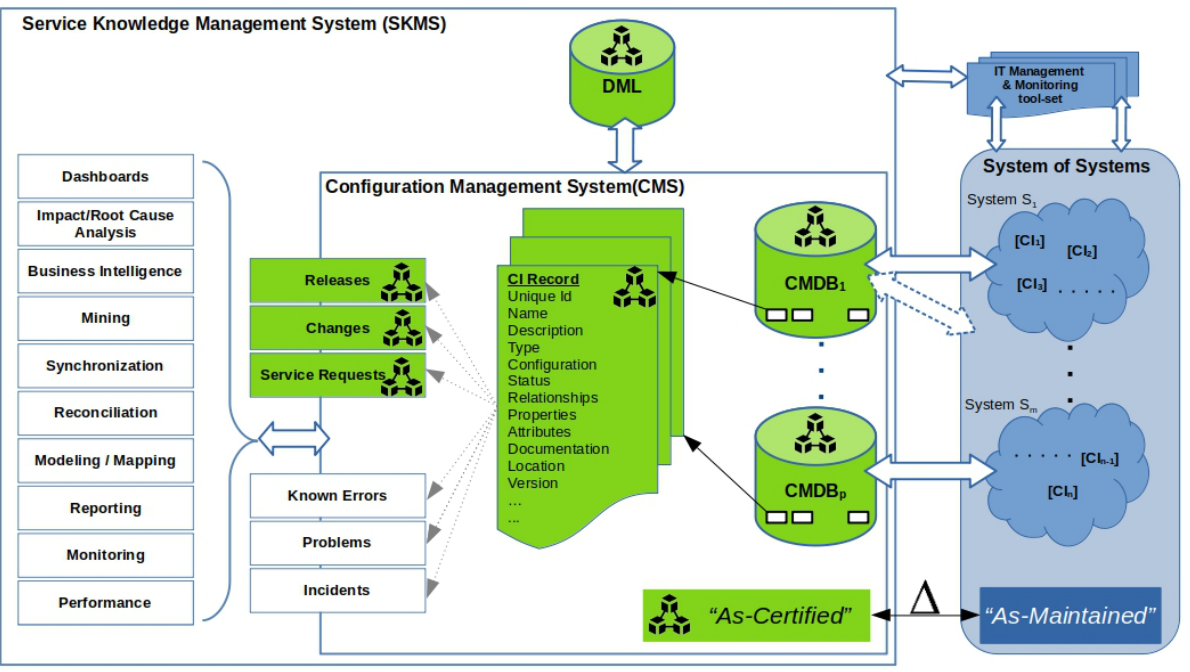
Figure 2. High-level components of